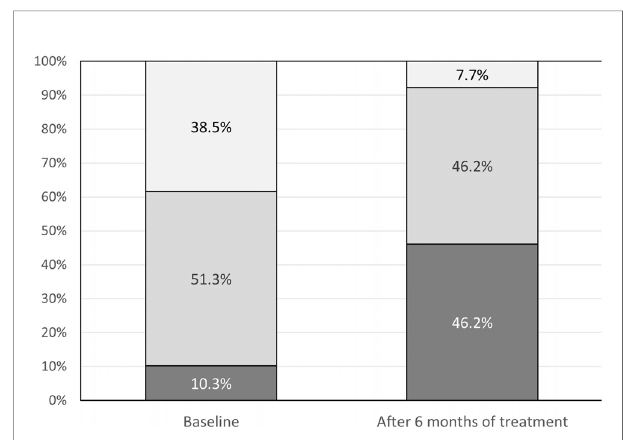
FIGURE 1 | Glucose metabolism status at baseline and after 6 months of treatment: dark grey – diabetes, medium grey - prediabetes, light grey – normal glucose